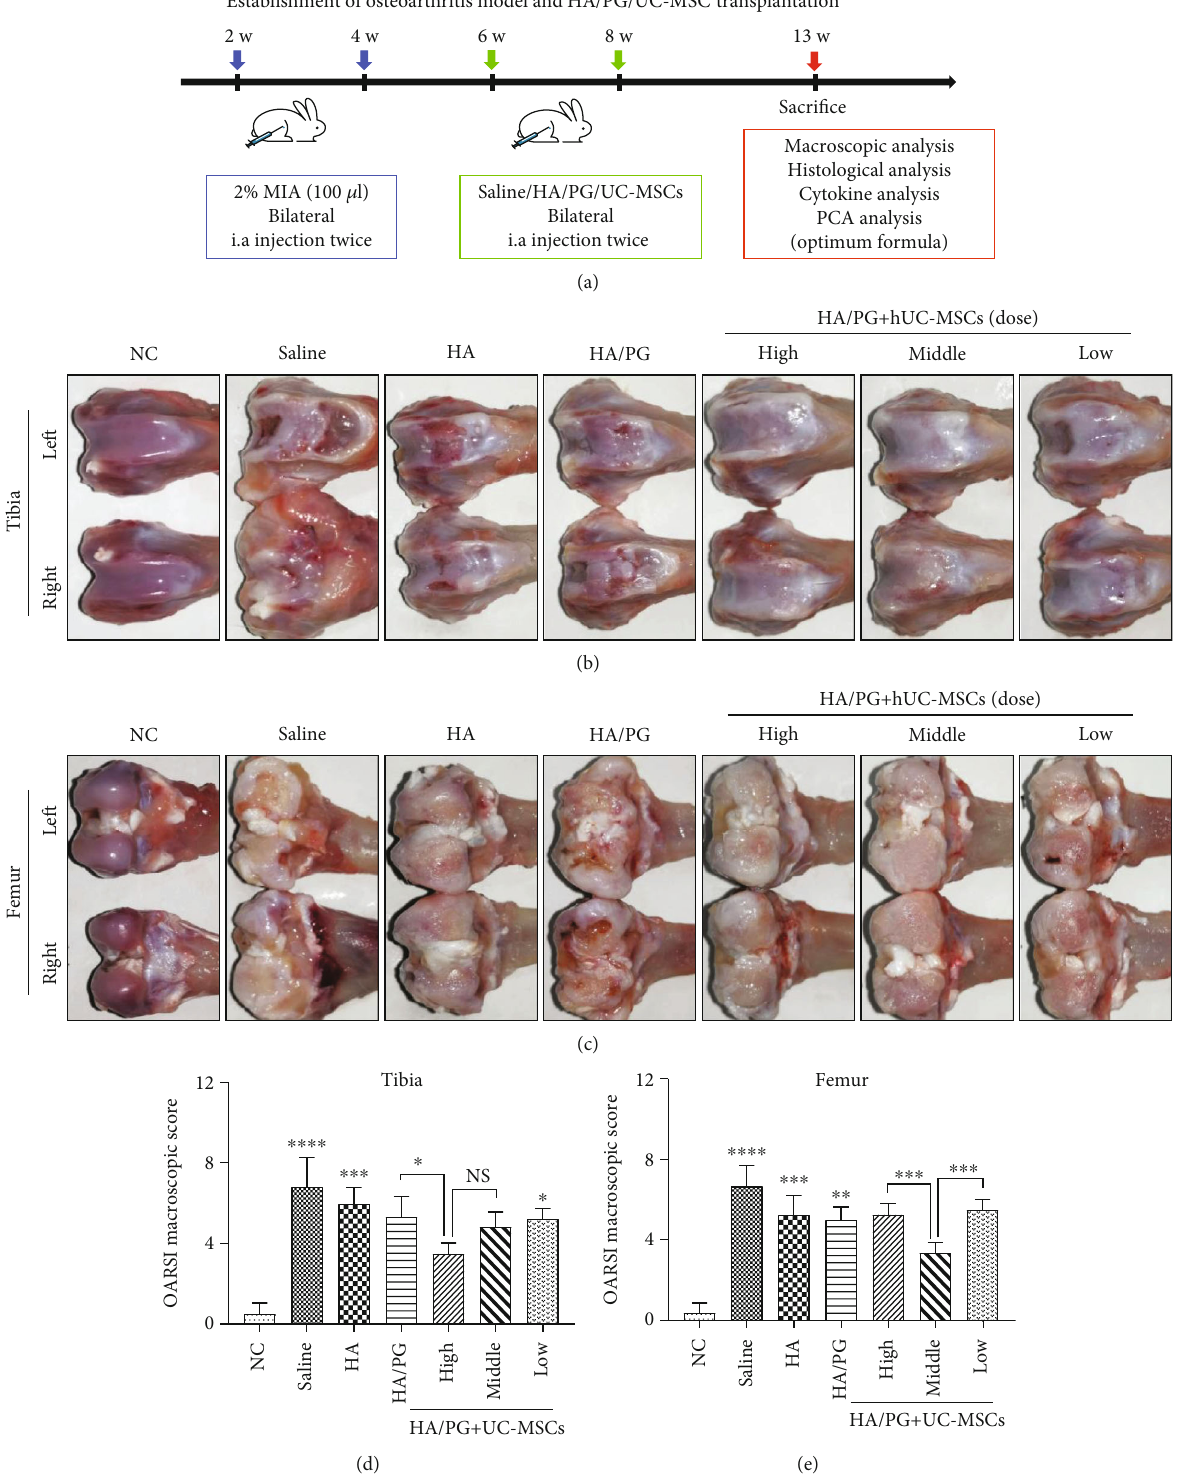
Figure 1: Pathological changes of articular cartilage in OA rabbits with UC-MSC and/or HA/PG composite administration. (a) Schedule of the MIA-induced OA rabbit model with UC-MSC and/or HA/PG composite administration. (b, c) Representative macroscopic images of the tibias (b) and femurs (c) in the indicated groups with intra-articular (i.a.) injection of saline, HA, HA/PG, high/middle/low dose of UC-MSCs+HA/PG hydrogels at week 13, respectively. Rabbits without any treatment were served as negative controls (NC). (d, e) Statistical analysis of the OARSI macroscopic score of tibias (d) and femurs (e) in the aforementioned 7 groups. ∗ P < 0 : 05 ; ∗ P < 0 : 01 ; ∗∗∗ P < 0 : 0001 ; ∗∗∗∗ P < 0 : 00001 ; NS: not signi fi